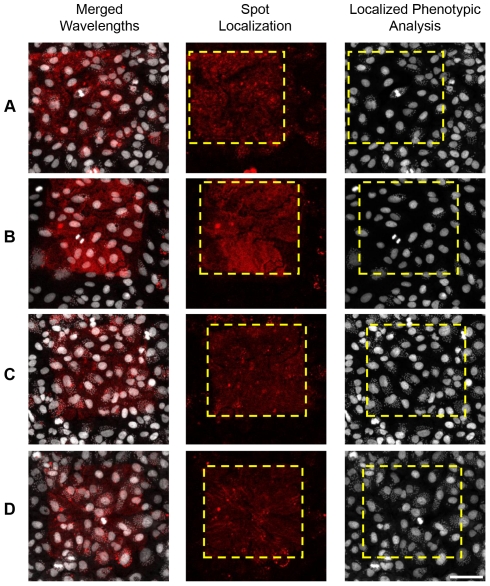
Genome-wide microarray screening results.Examples of data from the primary screening performed over microarrays showing that the knockdown of some genes inhibited infection by T. cruzi parasites. In (A) and (B), two examples are shown of genes selected as hits: PCDHA13 (protocadherin alpha 13) and C20orf200 (chromosome 20 open reading frame 200), respectively. Scrambled siRNA (C) was used as a negative control and p65 siRNA (D) was used as a transfection control (see Materials and Methods). Cells and parasites are pseudocolored in white, while siRNA spots are pseudocolored in red. The yellow dashed boxes outline the spot region. Cells within the spot were silenced for the indicated genes and compared with the cells lying outside the spot for their infection ratio and parasite load through software analysis. Scale bar represents 80 µm.